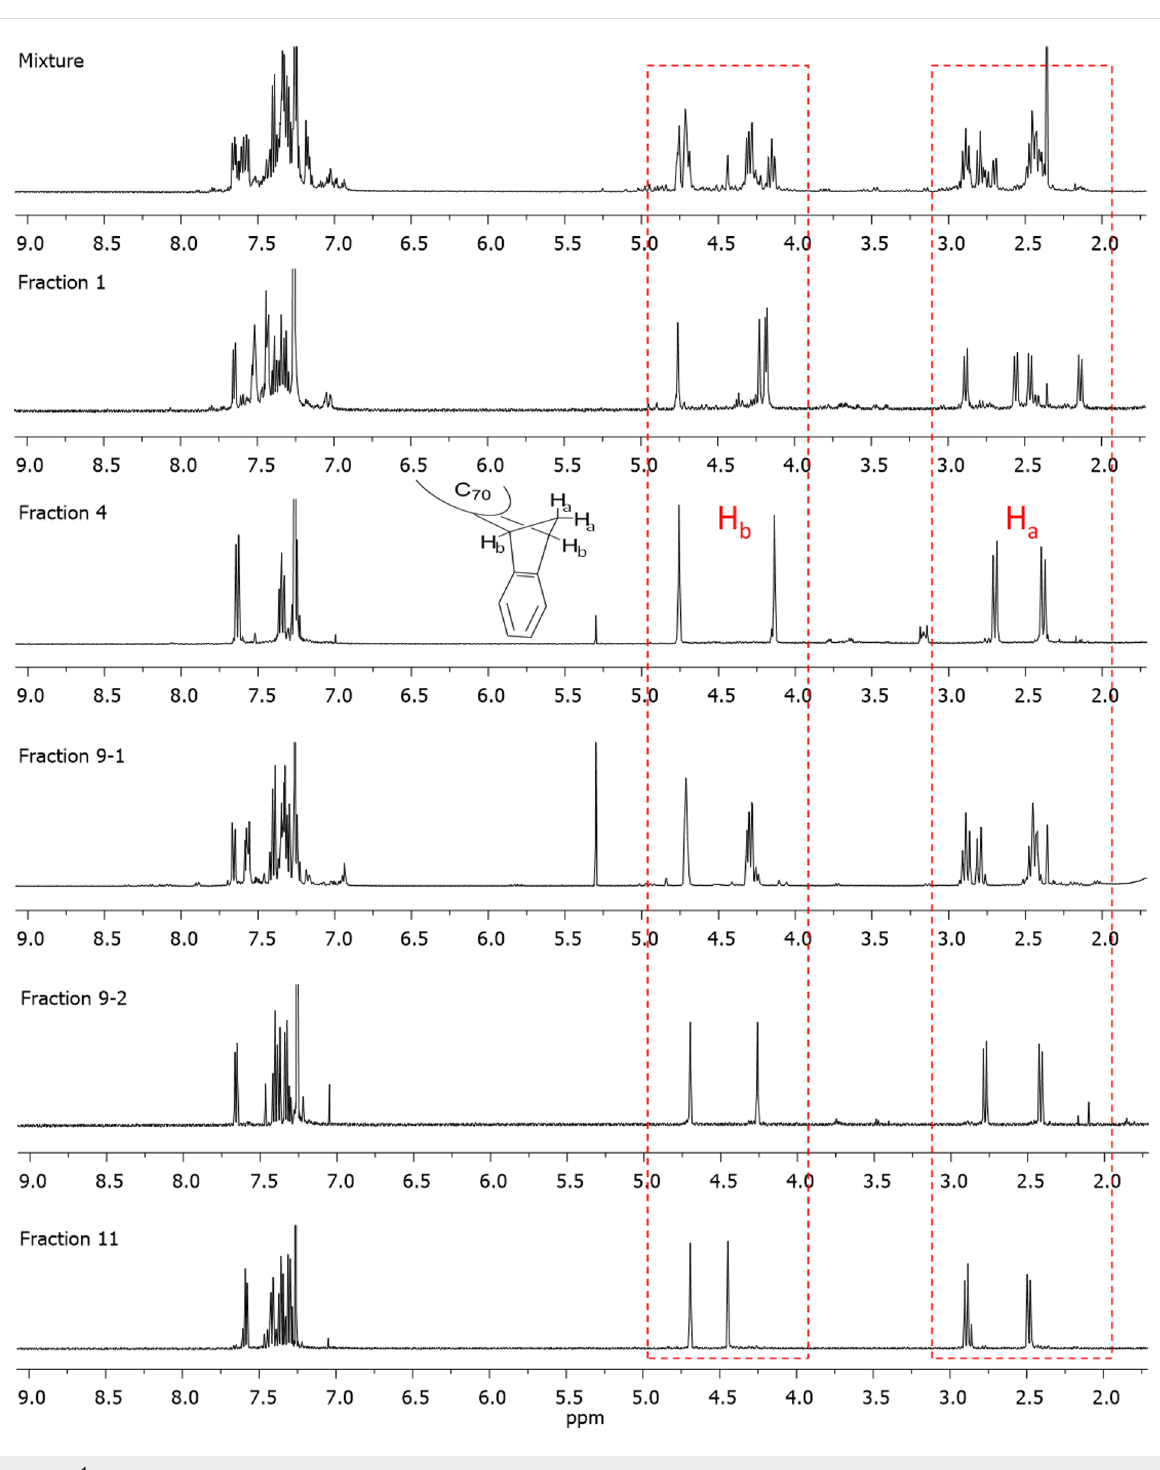
Figure 4: 1 H NMR spectrum of IC 70 BA fractions containing a major isomer species.